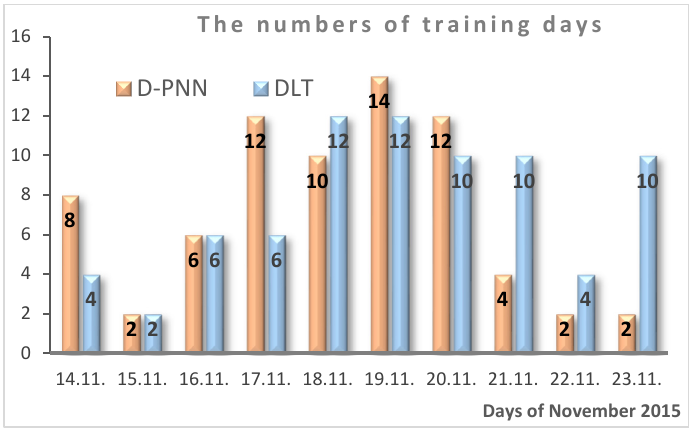
Figure 12. The predetermined initial numbers of the trainable data day series are re-evaluated for selected pattern similarity in the development of solar radiation models.